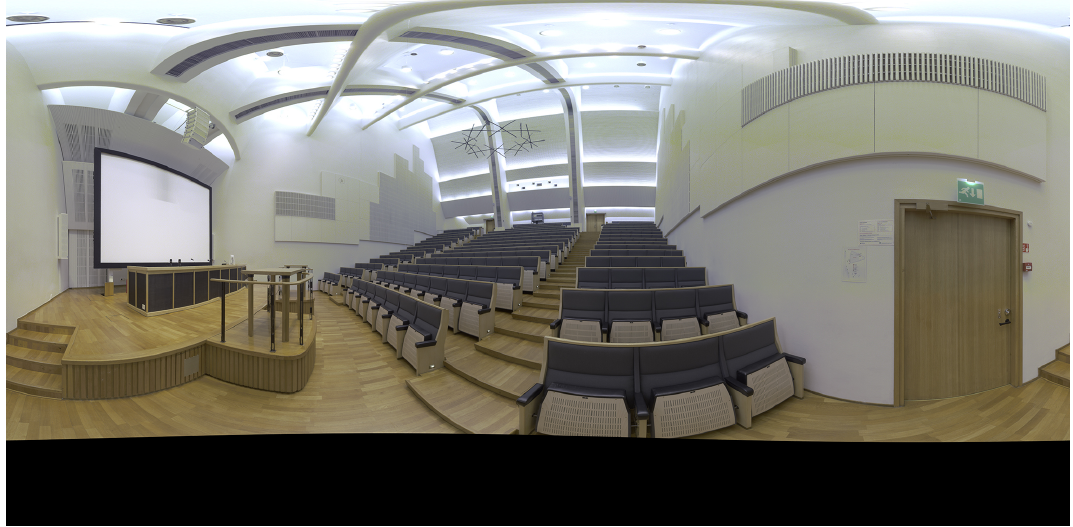
Figure 7. The 360 ◦ panoramic image taken with the TLS